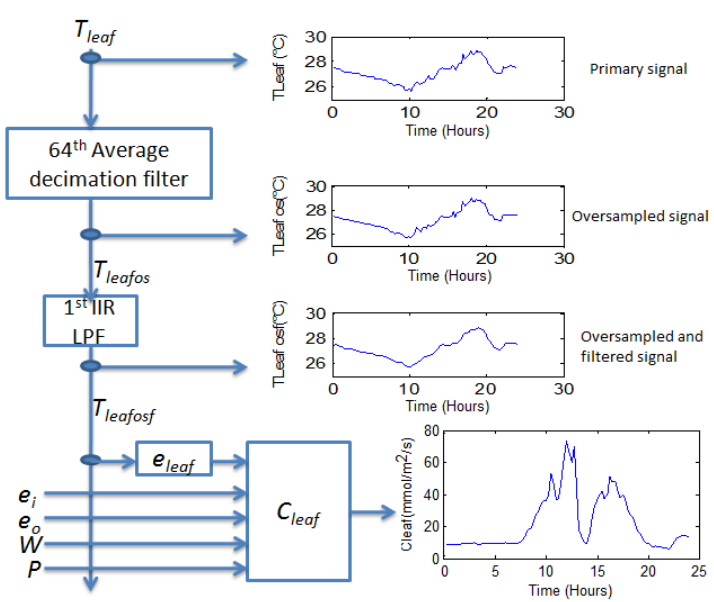
Figure 5. Stomatal conductance estimation signal processing